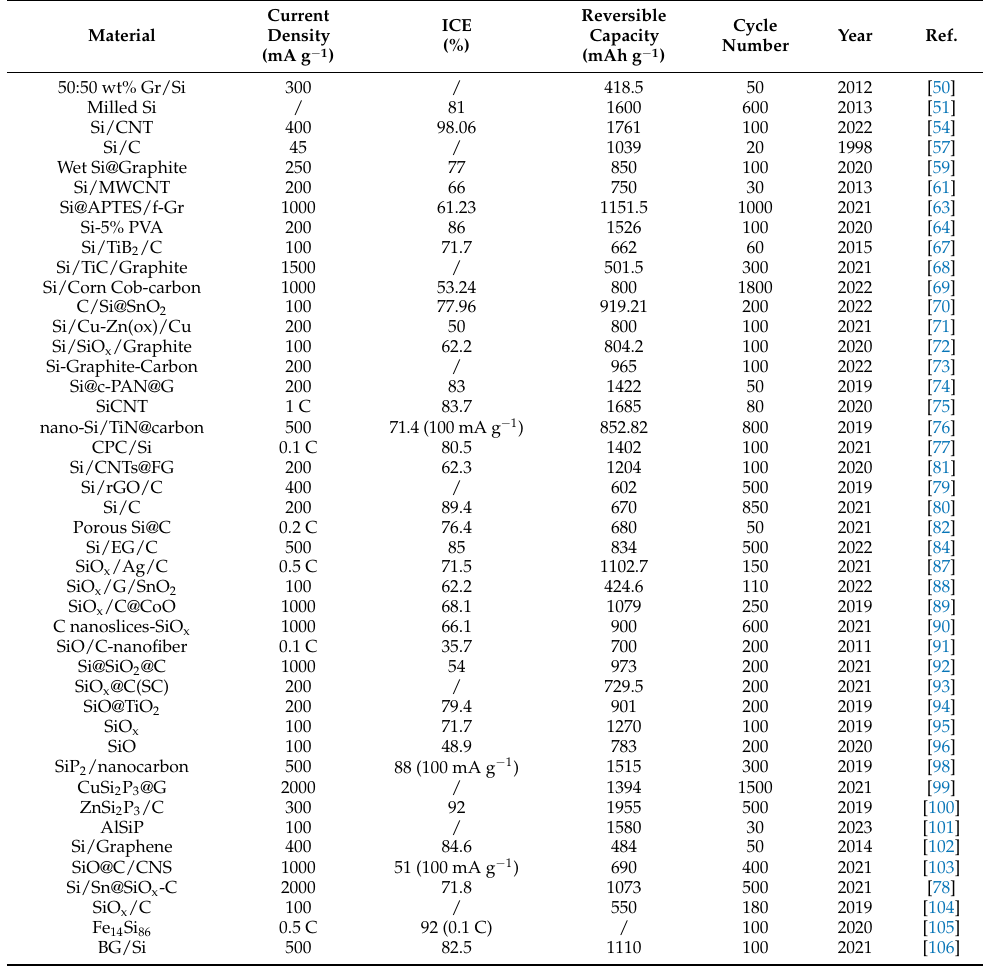
Table 1. Summary of recent ball-milling-based Si materials for LIB.